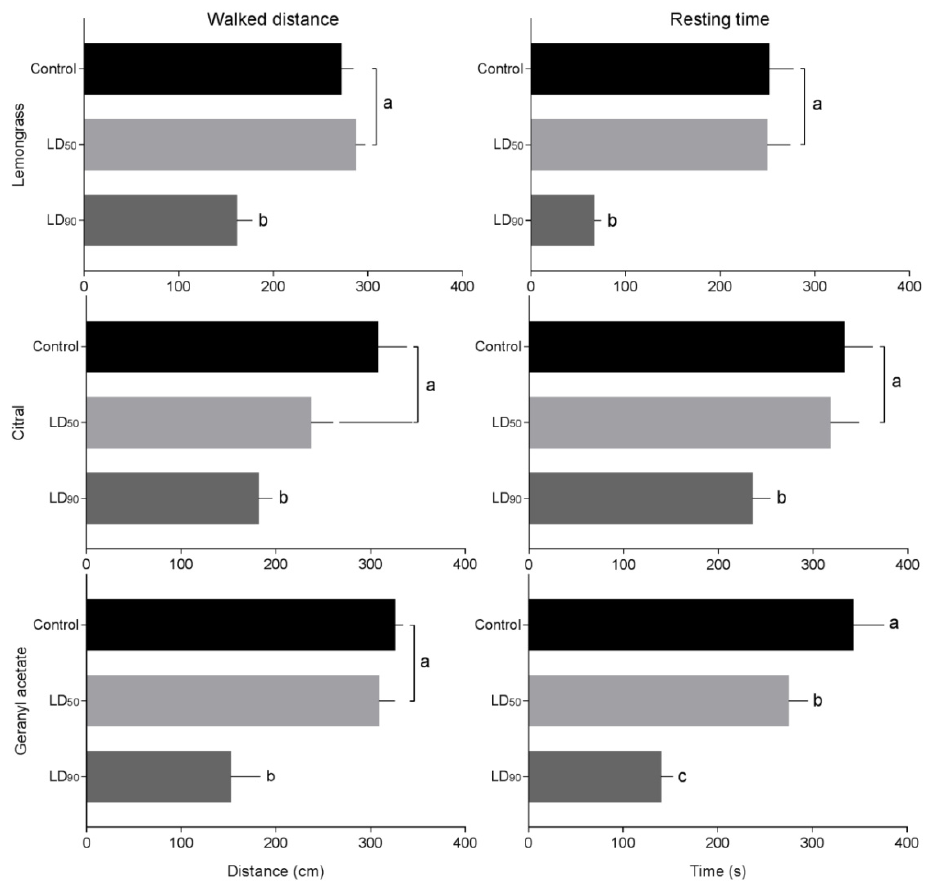
Figure 6. Distance walked and resting time (mean ± SEM) of S. granarius subjected to lemongrass essential oil, citral, and geranyl acetate (control, LD 50 , and LD 90 estimated values) for 10 min. Treatments (mean ± SEM) differ at p < 0.05 (Tukey’s mean separation test). Values in the same column with different letters show significant differences by Tukey’s HSD test.